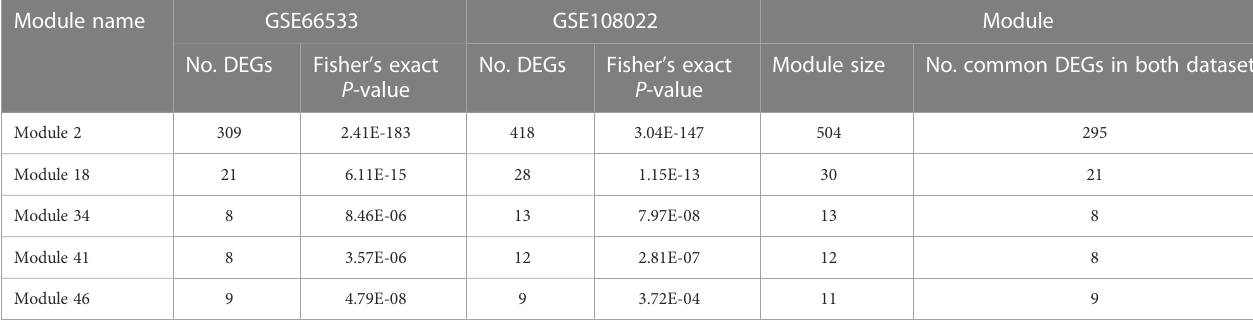
TABLE 2 Modules associated with fusion status in both discovery